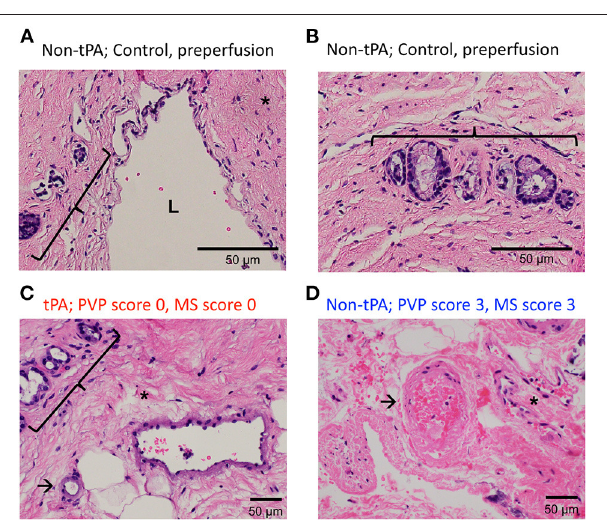
FIGURE 5 | Representative H&E histology of preperfusion common bile ducts (A) show bile duct lumen (L) and normal mural stroma (asterisk), periluminal peribiliary glands (bracket) and (B) deep peribiliary glands (bracket). H&E after 12h of NMP of tPA liver (C) shows normal peribiliary arterioles (arrows), unremarkable peribiliary glands (bracket), and no injury to MS (asterisk) vs. non-tPA liver histology (D) shows arteriolonecrosis (arrow) and necrotic mural stroma (asterisk) indicative of grade 3